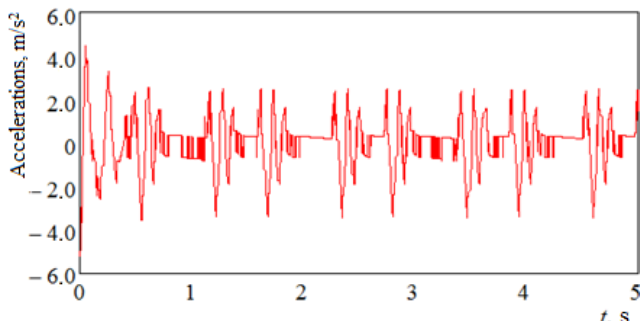
Figure 13. Acceleration in the center of mass of the hopper wagon.